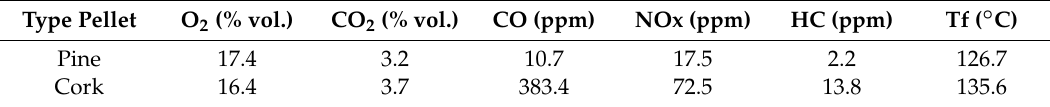
Table 1. Emissions from exhaust gases of biomass combustion.